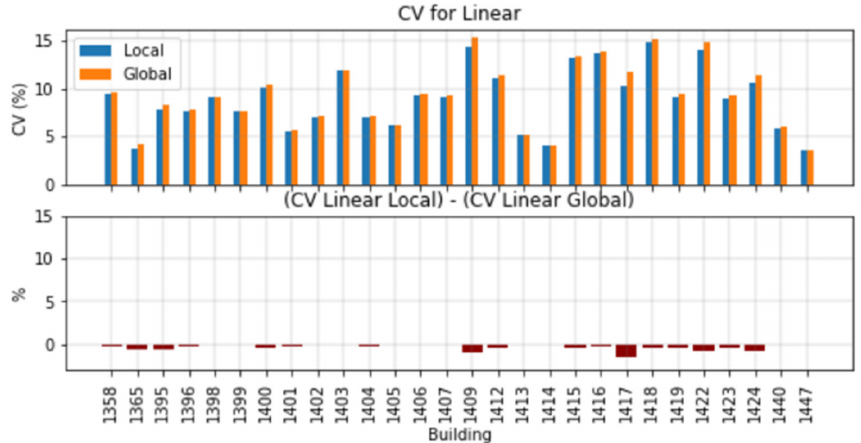
Figure 5. Comparison (in the upper figure) and difference (in the lower figure) between the CV obtained from local and global Linear models on test